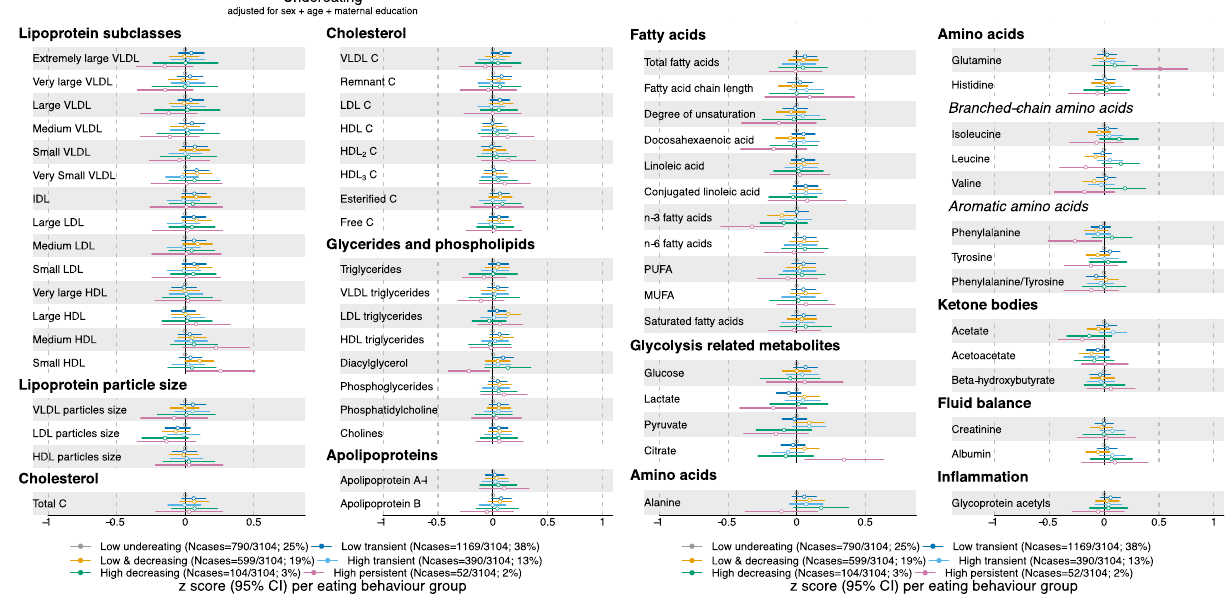
Figure 3. Estimates refer to change in standardised metabolic trait concentration at 16 years in each undereating trajectory, in reference to the “low undereating” trajectory (gray dot). Error bars = 95% confidence intervals (CI). For lipoprotein subclasses, the total lipids (= triglycerides + phospholipids + total cholesterol) point estimate (and CIs) of each 14 subclasses is presented. Estimated beta coefficients and corresponding 95% CIs for particle concentration and specific lipids in each lipoprotein subclass are given in Figure S2a–c, Supplementary Material and Table S2, Supplementary File. Analyses adjusted for sex, age at metabolite measure and maternal education. Note Association where CIs do not cross 0, p-value < 0.05; Filled dot: Association meets the p-value threshold of < 0.003. C cholesterol, IDL intermediate-density lipoprotein, LDL low-density lipoprotein, HDL high-density lipoprotein, VLDL very low-density lipoprotein, MUFA monounsaturated fatty acids, PUFA polyunsaturated fatty acids. Note Filled dot: CI do not include the null after multiple